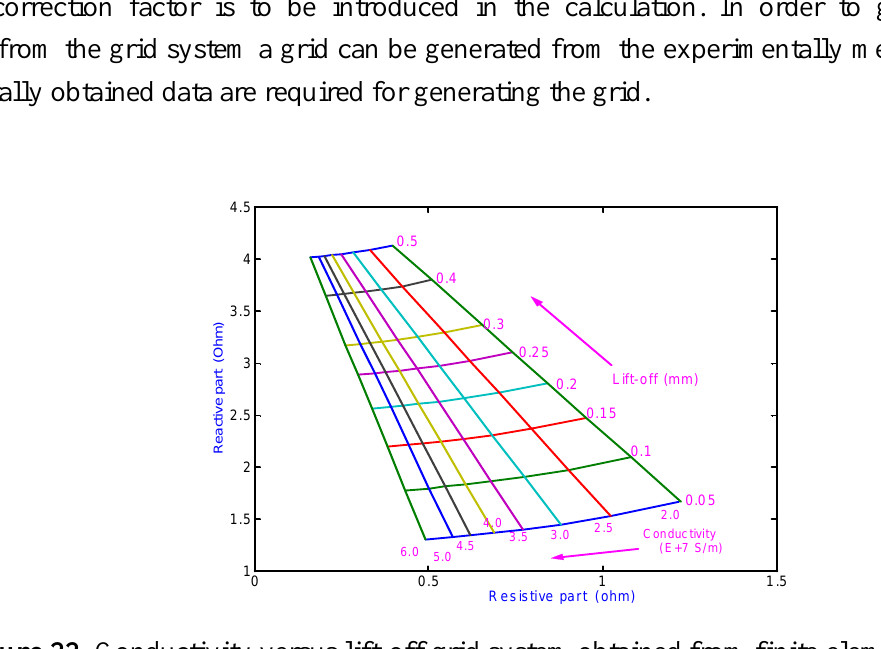
Figure 22. Conductivity versus lift-off grid system obtained from finite element model.